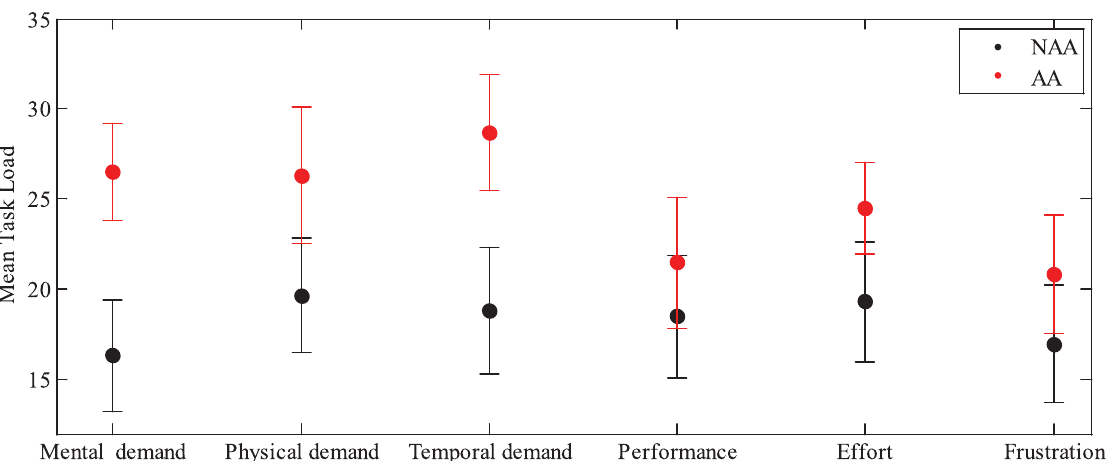
Fig 5. Mean workload metrics for different experimental conditions performed in ME. Results are based on NASA – TLX. Error bars represent standard error. Mental demand scores in NAA and AA are found to be statistically significant at the 0.05 level while no statistical significance is observed for the remaining